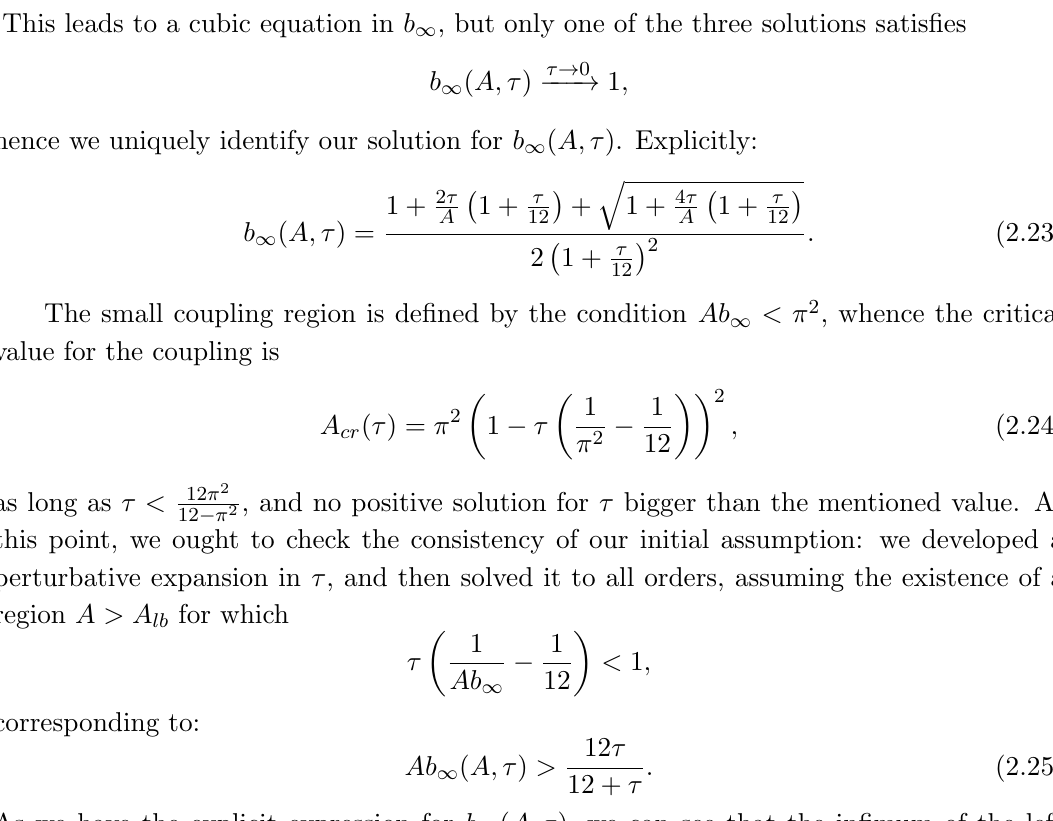
, for (cid:28) = 0 : 1 (left) and (cid:28) = 0 : 5 k